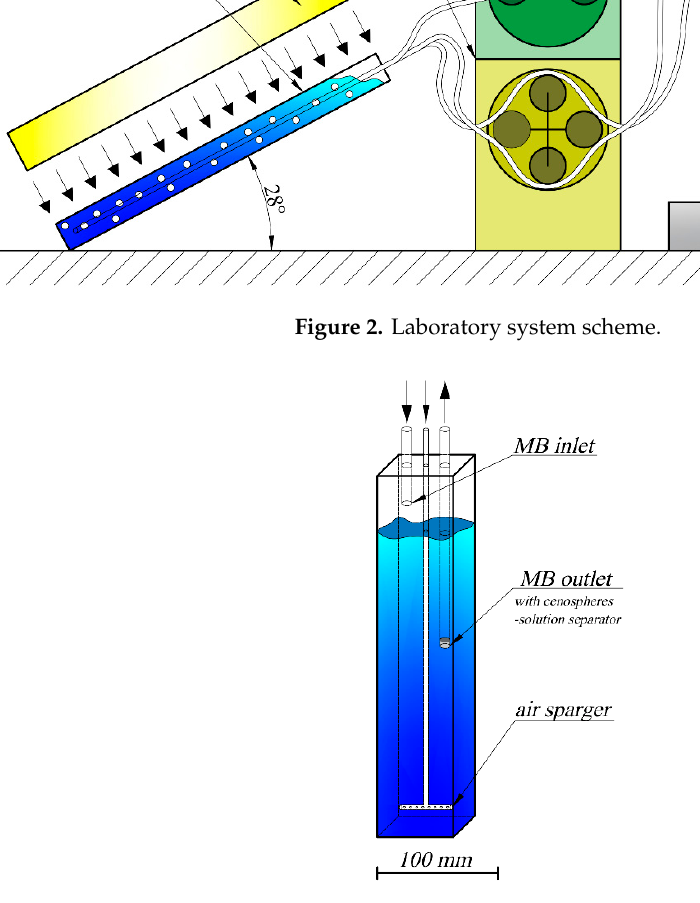
Figure 3. Geometry of air-sparged reactor and scheme of media inlets and outlets.